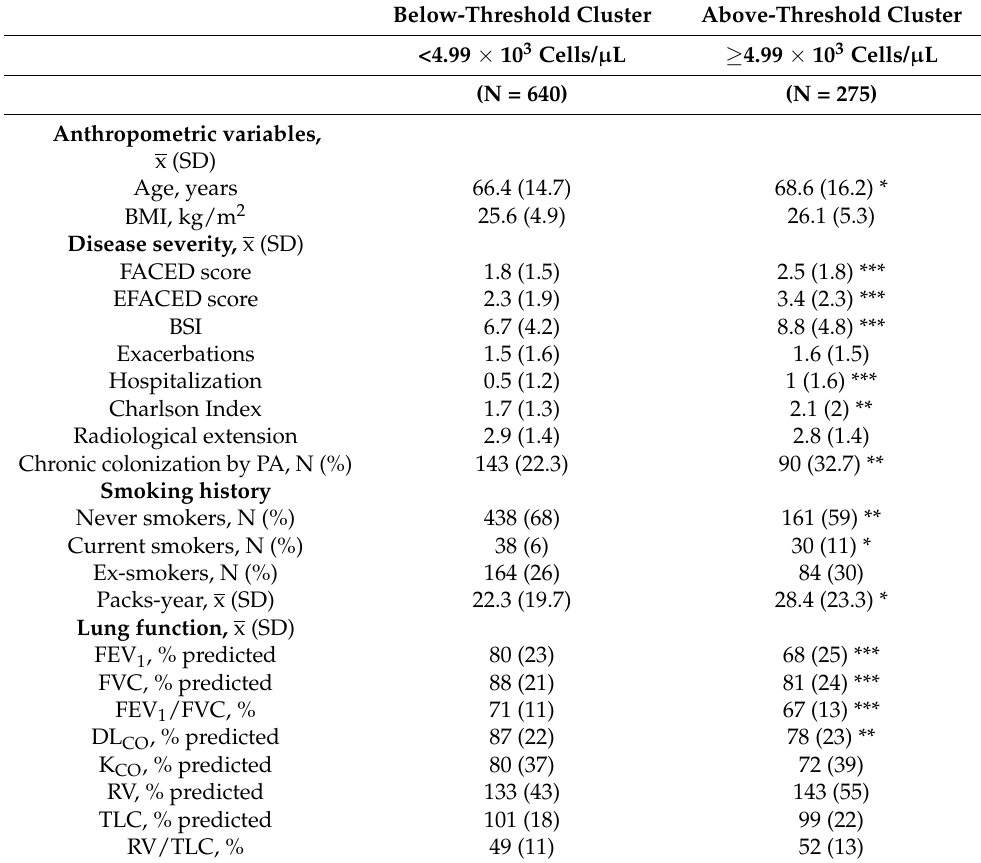
Table 2. General characteristics in the two clusters of bronchiectasis patients, excluding those with COPD.